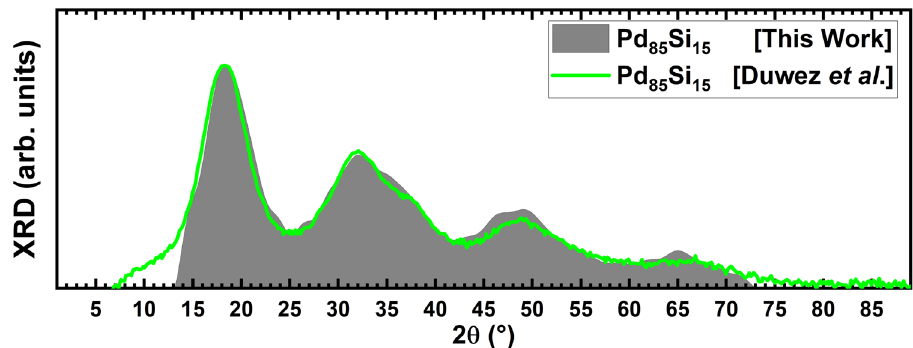
Figure 4. Comparison of the XRD pattern obtained from the experimental results of Ref. 2 ( c = 15 at.%), green line, with our simulations, dark solid profile. See